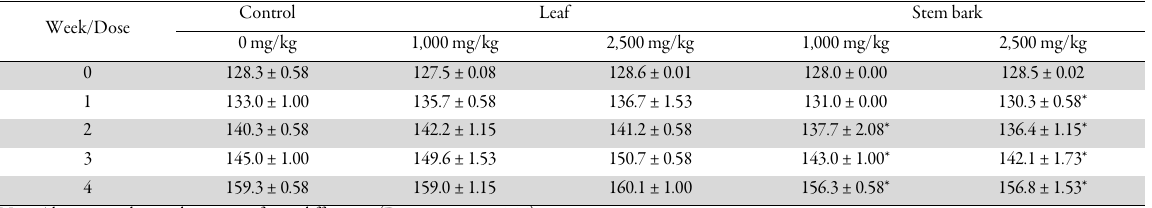
Table 2. The effect of Cola millenii extracts on body weight gain in the control and treated rats after 28 days exposure Week/Dose